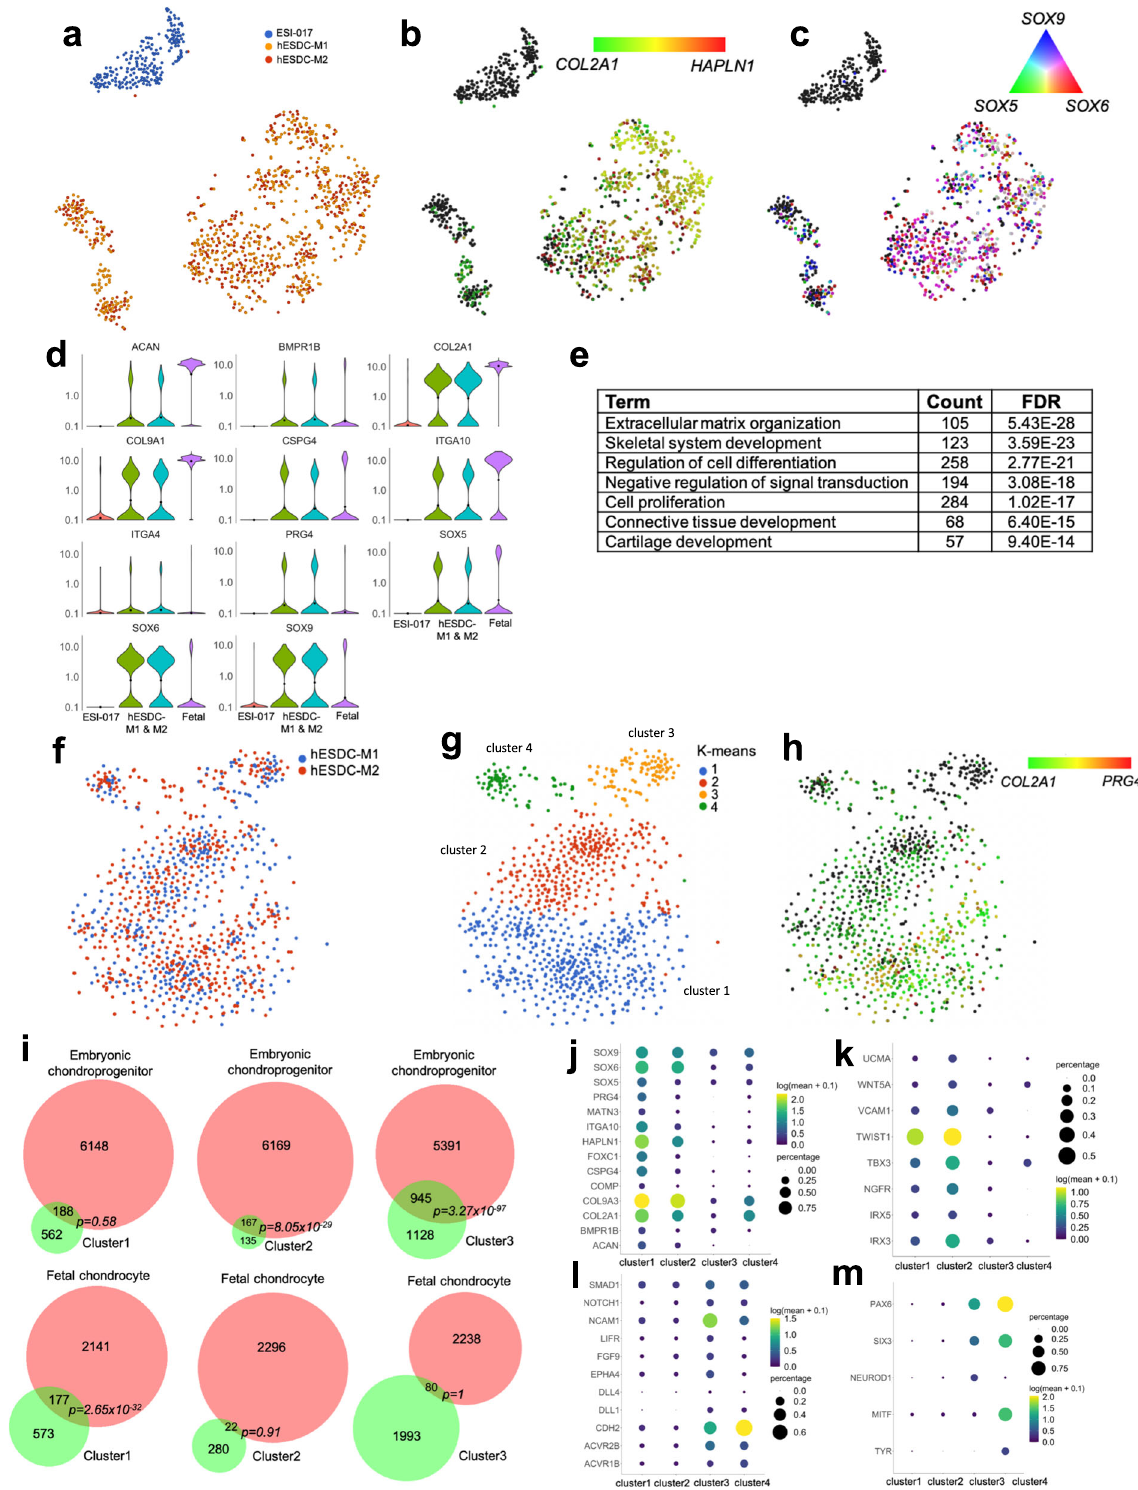
Fig. 2 Transcriptional pro fi ling of membrane embedded hESDC-M. a t-SNE plot of 1173 single cells sequenced, generated from ESI-017 cells ( n = 1, blue) or hES-derived chondrocytes digested from membranes at d40 of differentiation ( n = 2 batches in red and orange). b, c t-SNE plots depicting expression of indicated genes at single cell resolution. d Violin plots for gene expression of selected chondrogenic genes; fetal chondrocyte expression data are shown for reference. e Selected gene ontology (GO) categories enriched in hESDC-M vs. ESI-017 cells based on genes with FDR < 0.05, >2-fold change. f Re-clustering, g k-means clustering and h PRG4 and COL2A1 expression levels of 965 hESDC-M cells. i Venn diagrams demonstrating overlap of genes strongly enriched (biomarker genes) in the indicated cluster with (top) genes enriched in embryonic chondroprogenitors isolated from 5 – 6 wk limbs vs. fetal chondrocytes isolated at 17 wks from knee joints analyzed by scRNA- Seq or (bottom) vice versa. i – m Expression of selected and biomarker genes in each cluster of